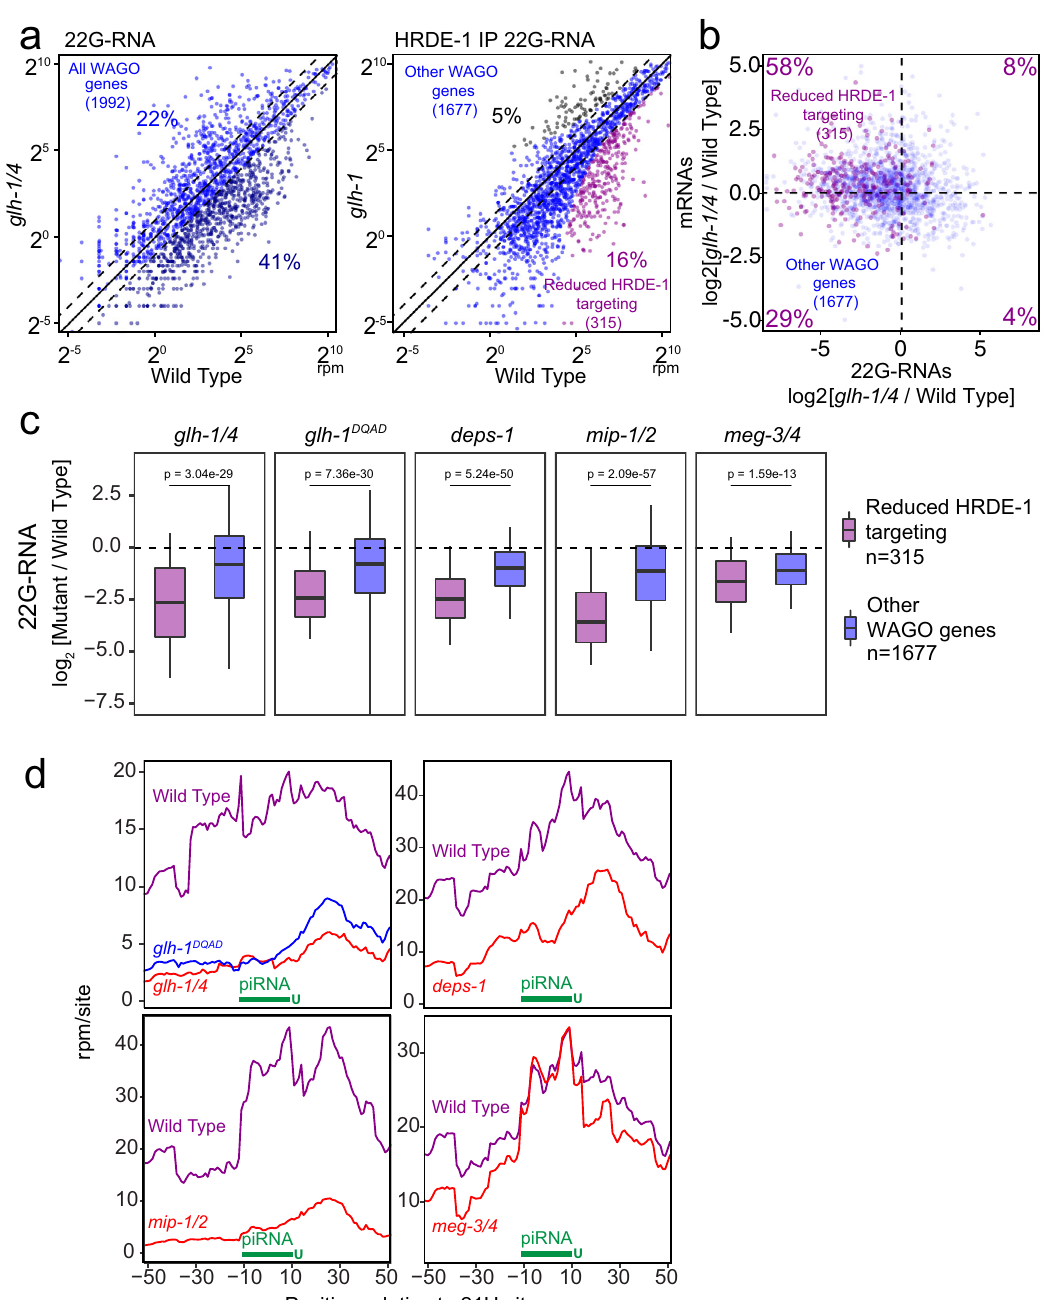
indicate the proportion of WAGO targets with reduced HRDE-1-associated 22G- RNAs in the glh-1 mutant that fall in that quadrant. c 22G-RNA changes for WAGO targets with reduced HRDE-1-associated 22G-RNAs in the glh-1 mutant versus all other WAGO targets in the indicated strains versus wild type worms. Statistical analysis was performed using a two-tailed Mann – Whitney Wilcoxon test. For all boxplots, lines display median values, boxes display fi rst and third quartiles, and whiskers display 5th and 95th percentiles. d Density of 22G-RNAs within a 100-nt windowaroundpredictedpiRNAtargetsitesinthe indicated strains.Computedby summing 22G-RNA density per piRNA targeting site inWAGO targets with reduced HRDE-1associated22G-RNAsinthe glh-1 mutant.Theplotsarecenteredonthe10 th nucleotide of